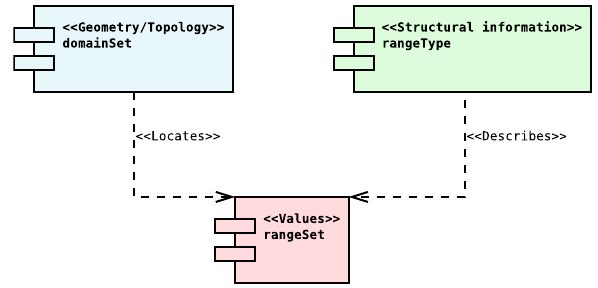
Figure 1: Principal elements of a GMLCOV instance and their